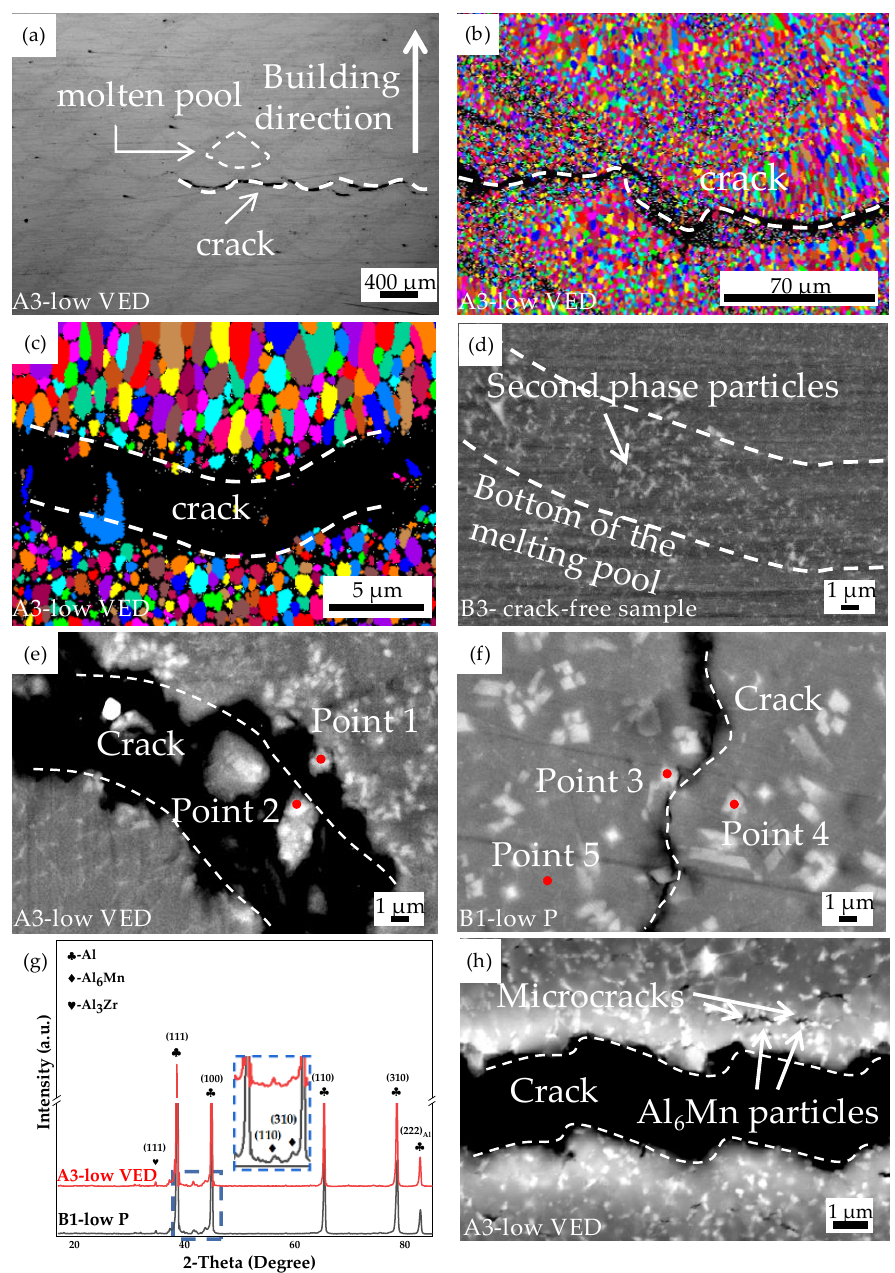
Figure 7. Cracking analysis: ( a ) OM image of A3, ( b ) EBSD images of A3, ( c ) EBSD images of A3, ( d ) BSE image of B3, ( e ) BSE image of A3, ( f ) BSE image of B1, ( g ) XRD analysis of A3 and B1, ( h ) ECC image of A3.